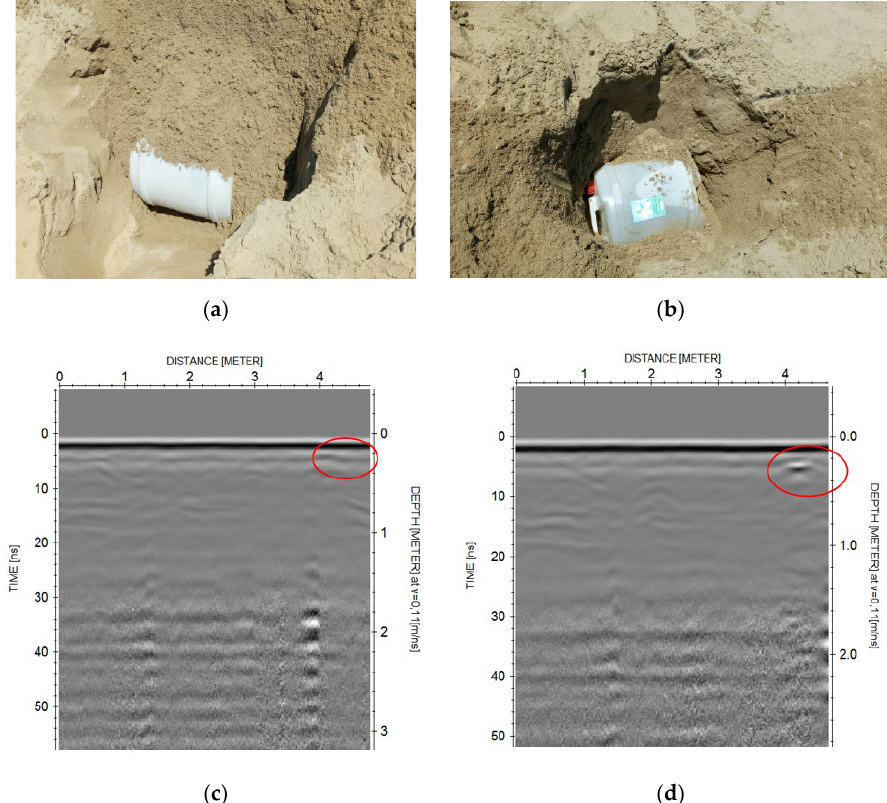
Figure 9. ( a ) Image of an empty container, ( b ) image of a container filled with water, ( c , d ) the resulting radargrams.